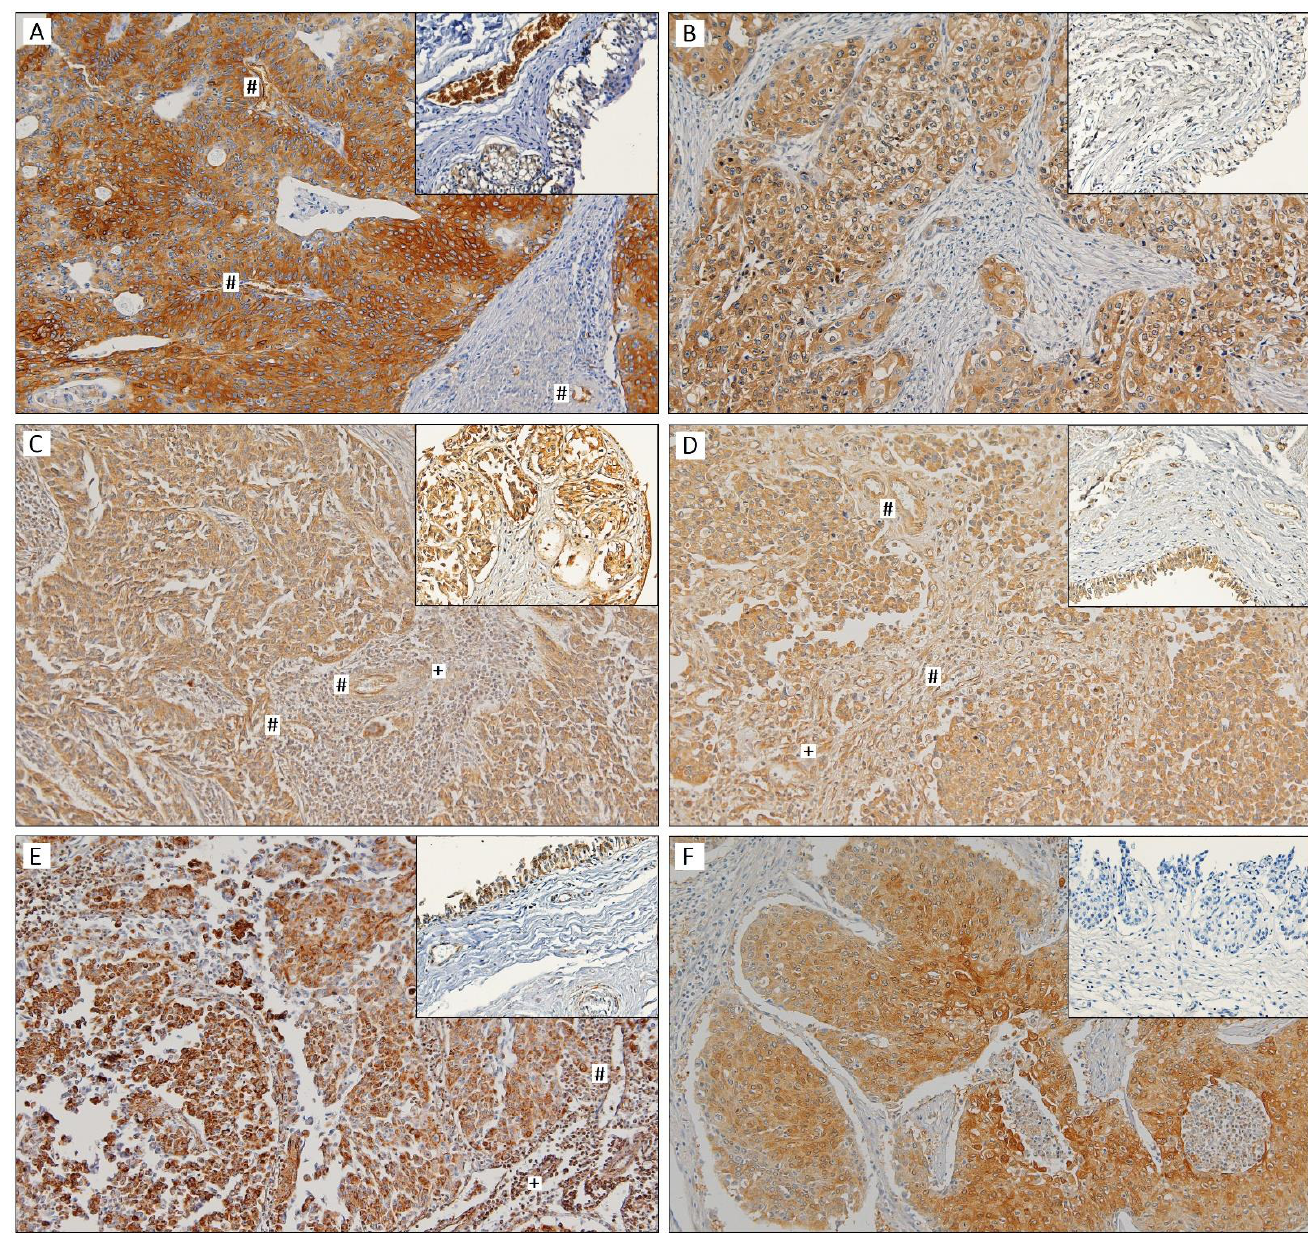
Figure 1. Tissue sections of urothelial bladder carcinoma showing positive immunoreactions in the malignant cells for GLUT1 ( A ), HK2 ( B ), PFKL ( C ), PKM2 ( D ), pPDH ( E ), and LDHA ( F ); immunostained non-neoplastic sections are also shown in insets. Cytoplasm positivity is observed in all of the immunoreactions; GLUT1 ( A ) immunoreaction also shows plasma membrane positivity. Positive tumour stroma (+) is observed in ( C ) (PFKL), ( D ) (PKM2), and ( E ) (pPDH). Positive blood vessels ( # ) are observed in ( A ) (GLUT1), ( C ) (PFKL), ( D ) (PKM2), and ( E ) (pPDH). Original magnification 100×.